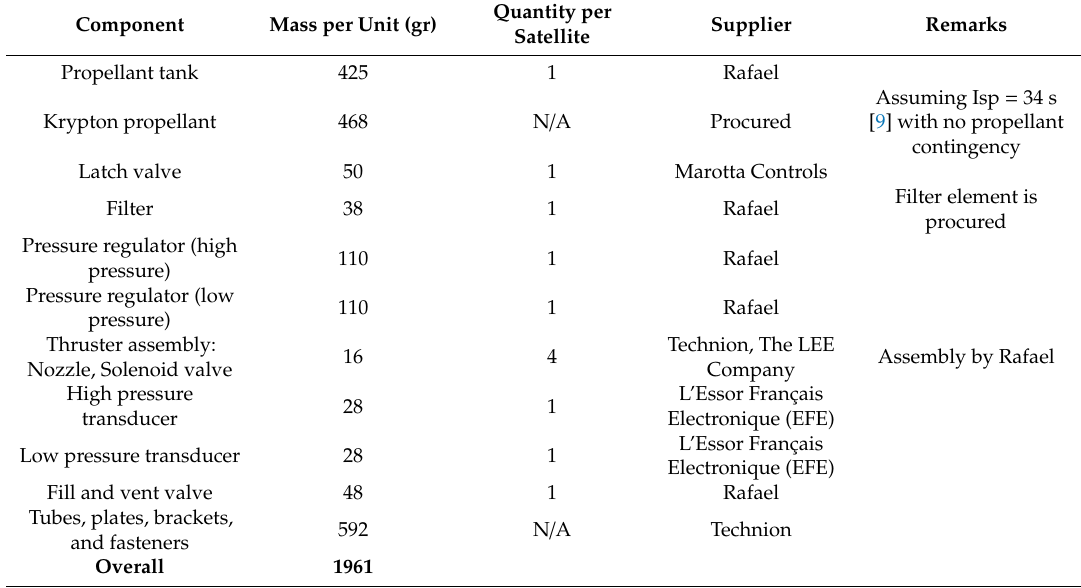
Table 2. Components of the Adelis-SAMSON satellites’ propulsion system.